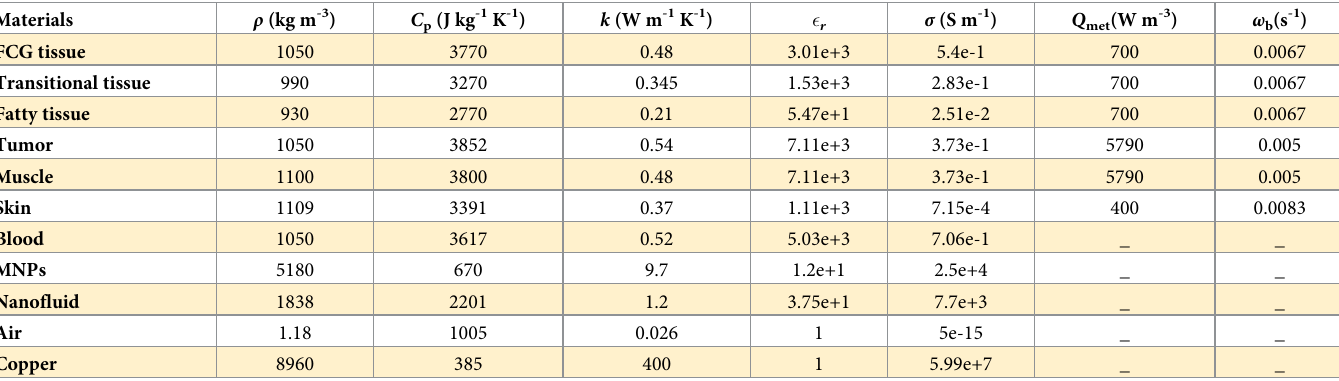
Table 1. Properties of different materials used for frequency of 400 kHz [6, 10, 45,